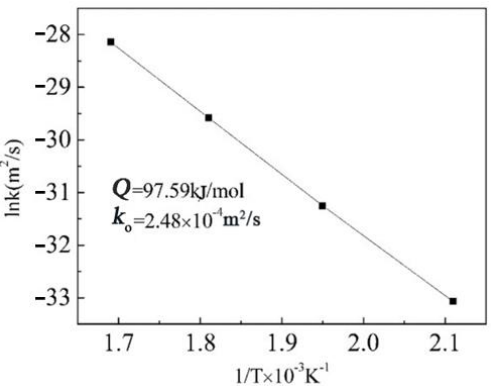
Figure 12. Relationship between interfacial diffusion layer of Al/Zn laminates and annealing tem-